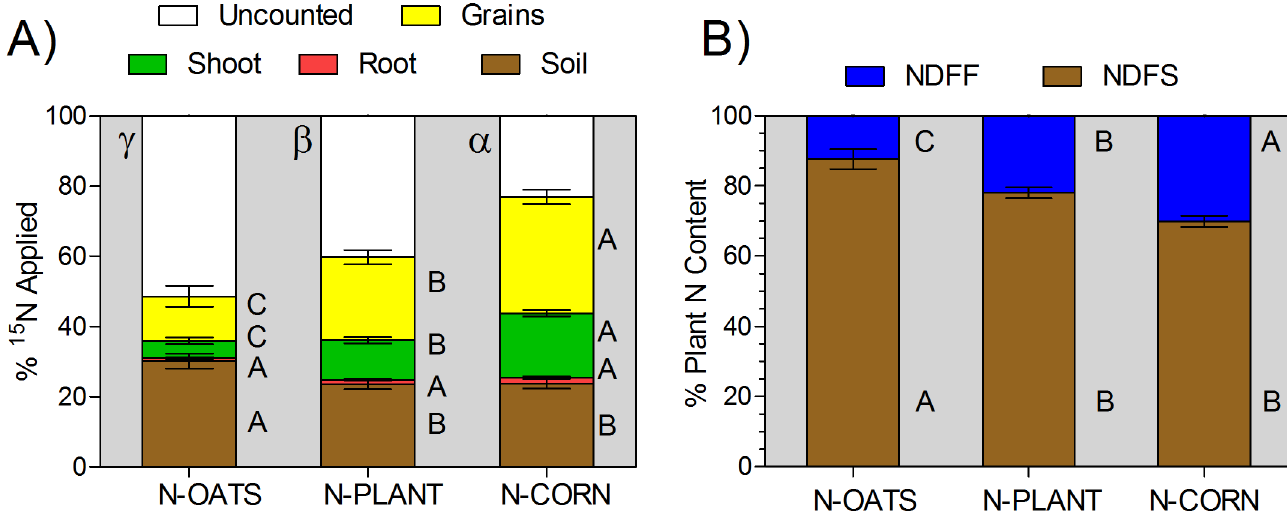
Fig 5. Fate of N from fertilizer (A) and N source used by corn plants (B). Uppercase letters compare means of the components of the fate of N from fertilizer (A) or N source (B) within each fertilizer N timing level. Greek letters compare total N fertilizer recovered in the columns. Bars represent the standard error for each